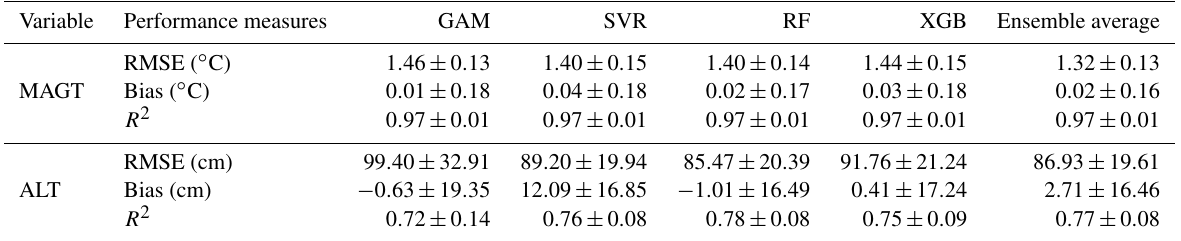
Table 2. The predictive performance (mean ± SD) of the mean annual ground temperature (MAGT) and active layer thickness (ALT) for the four statistical learning models and their ensemble means.